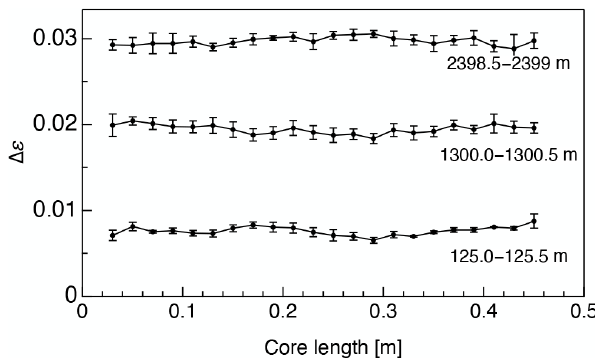
Figure 3. Examples of variations in (cid:49)ε along 0.5m long ice core samples obtained from continuous measurements. The span of the y axis equals the dielectric anisotropy of a single ice crystal. Error bars indicate standard deviations obtained from different resonance modes of the open resonator. Typically, eight different modes were obtained from each single 0.02m